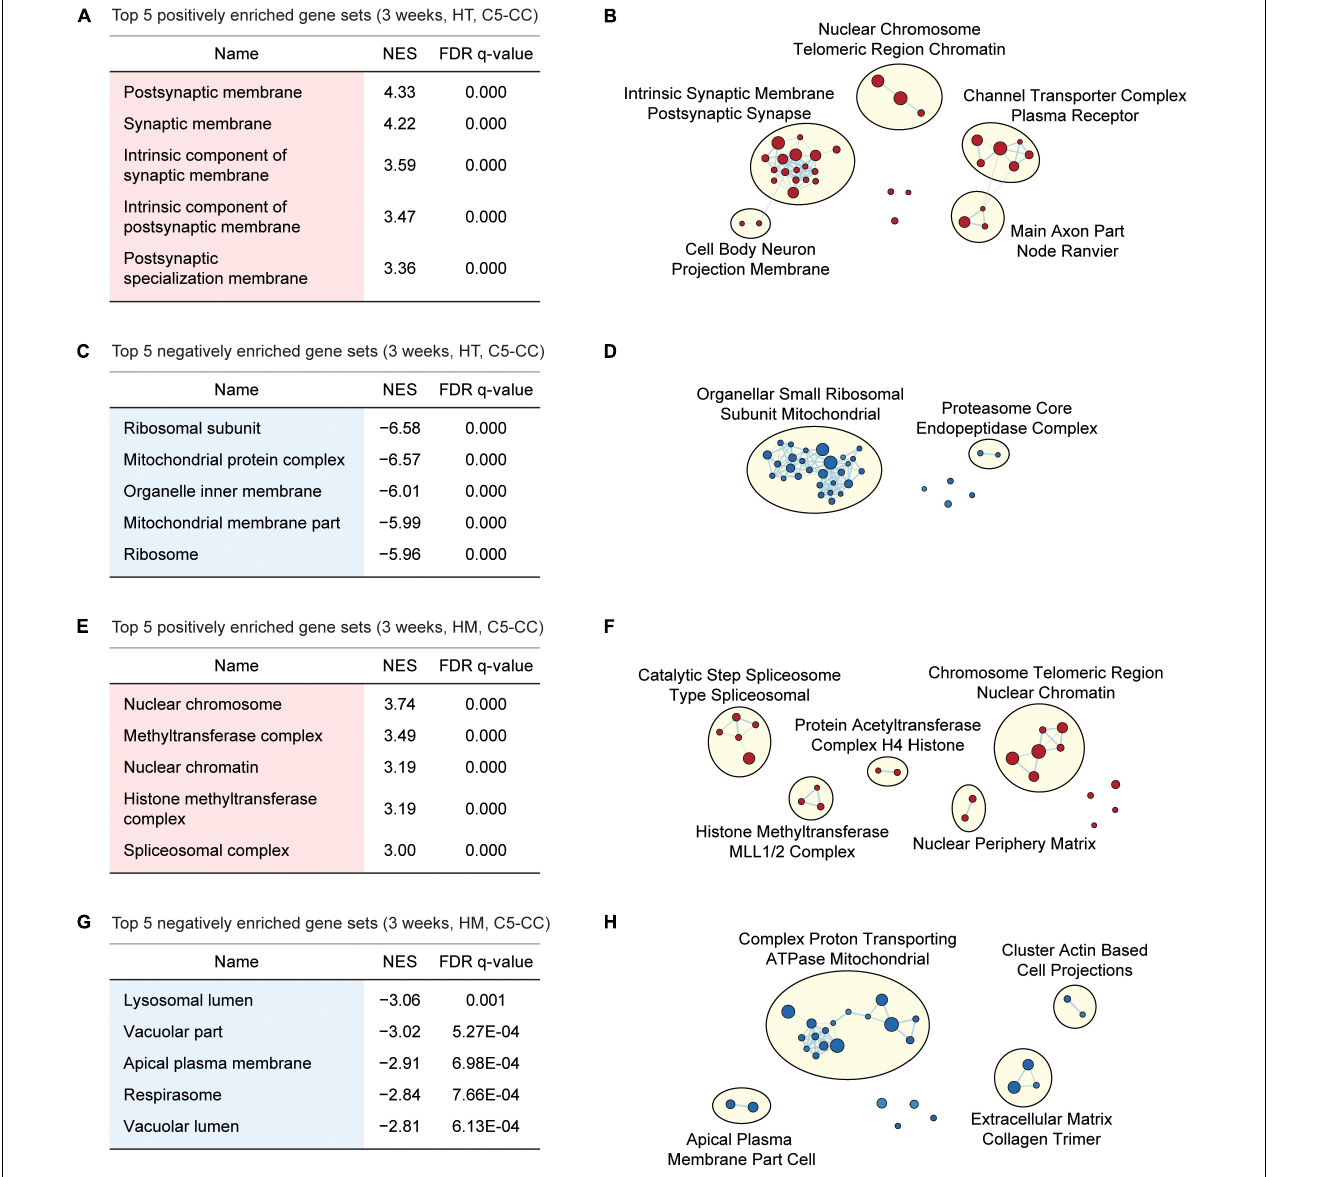
Table 6 (CC/BP/MF-Down tabs)], similar to the results from W3-HT